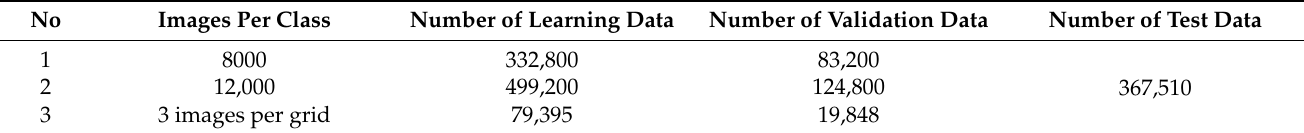
Table 2. Database description.